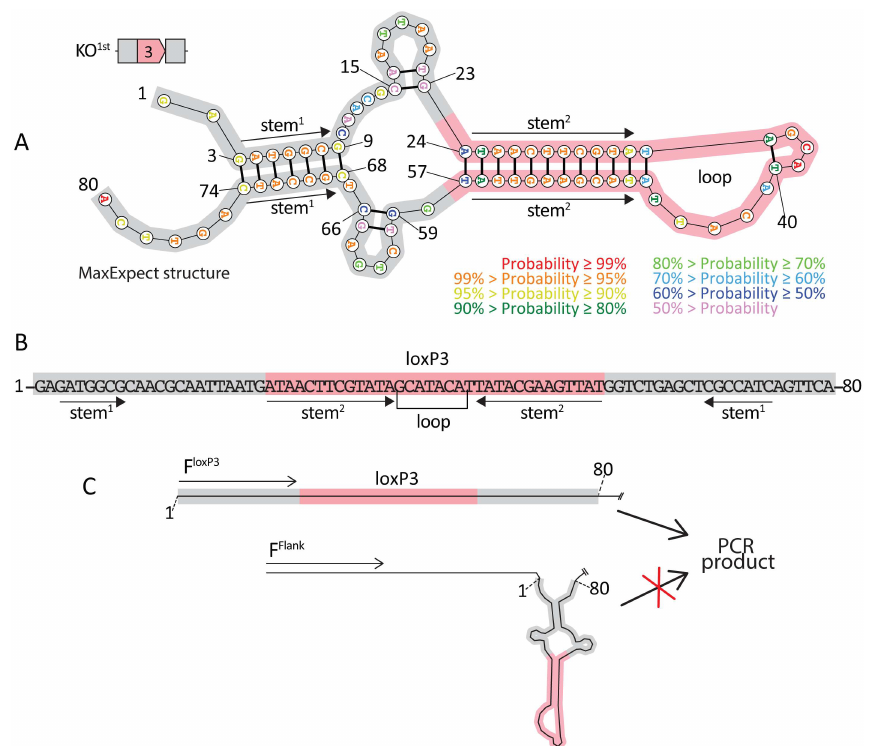
Fig 4. Predicted secondary structure of the synthetic loxP3 region. A. The 80 base synthetic loxP3 region was submitted to the RNAstructure Webserver; DNA was selected as the nucleic acid type and the default data settings were preserved.The RNAstructure MaxExpect result generatedby the Webserver is presented;this represents a structure formed due to high probability base pairing.The centrally located 34 bases is the loxP sequence(highlighted in pink), of which the first and last 13 bases are palindromic sequences. This facilitates intrastrand base-pairing permitting the formation of a hairpin loop structure. An additionalstem structure (stem 1 ) is predicted due to intrastrand base-pairing between the synthetic DNA sequences that flank the loxP site (highlightedin grey). The probability of base-pairing is illustratedby colour coding. B. A linear view of the 80 bases of the synthetic loxP3 region is annotatedwith the position of the stem and loop structures. C. Primers that bind sequencesthat are capable of intrastrandbase-pairing may compete with intrastrand base-pairing, stabilizingthe template and permitting PCR to proceed. In contrast, primers that bind in the regions flanking the synthetic loxP3 region cannot prevent secondarystructure formation and consequently PCR of these templates may be